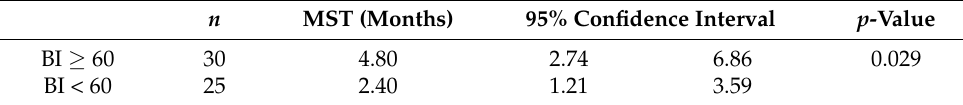
Table 6. Survival time of patients with a BI ≥ 60 versus those with a BI < 60. n MST